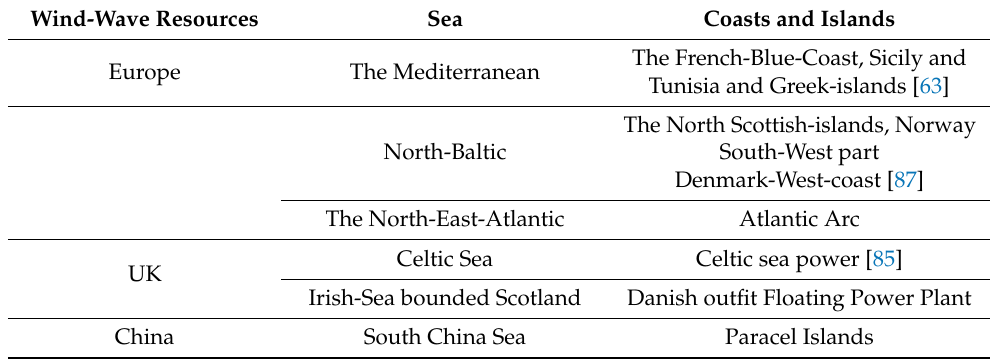
Table 2. The site location of